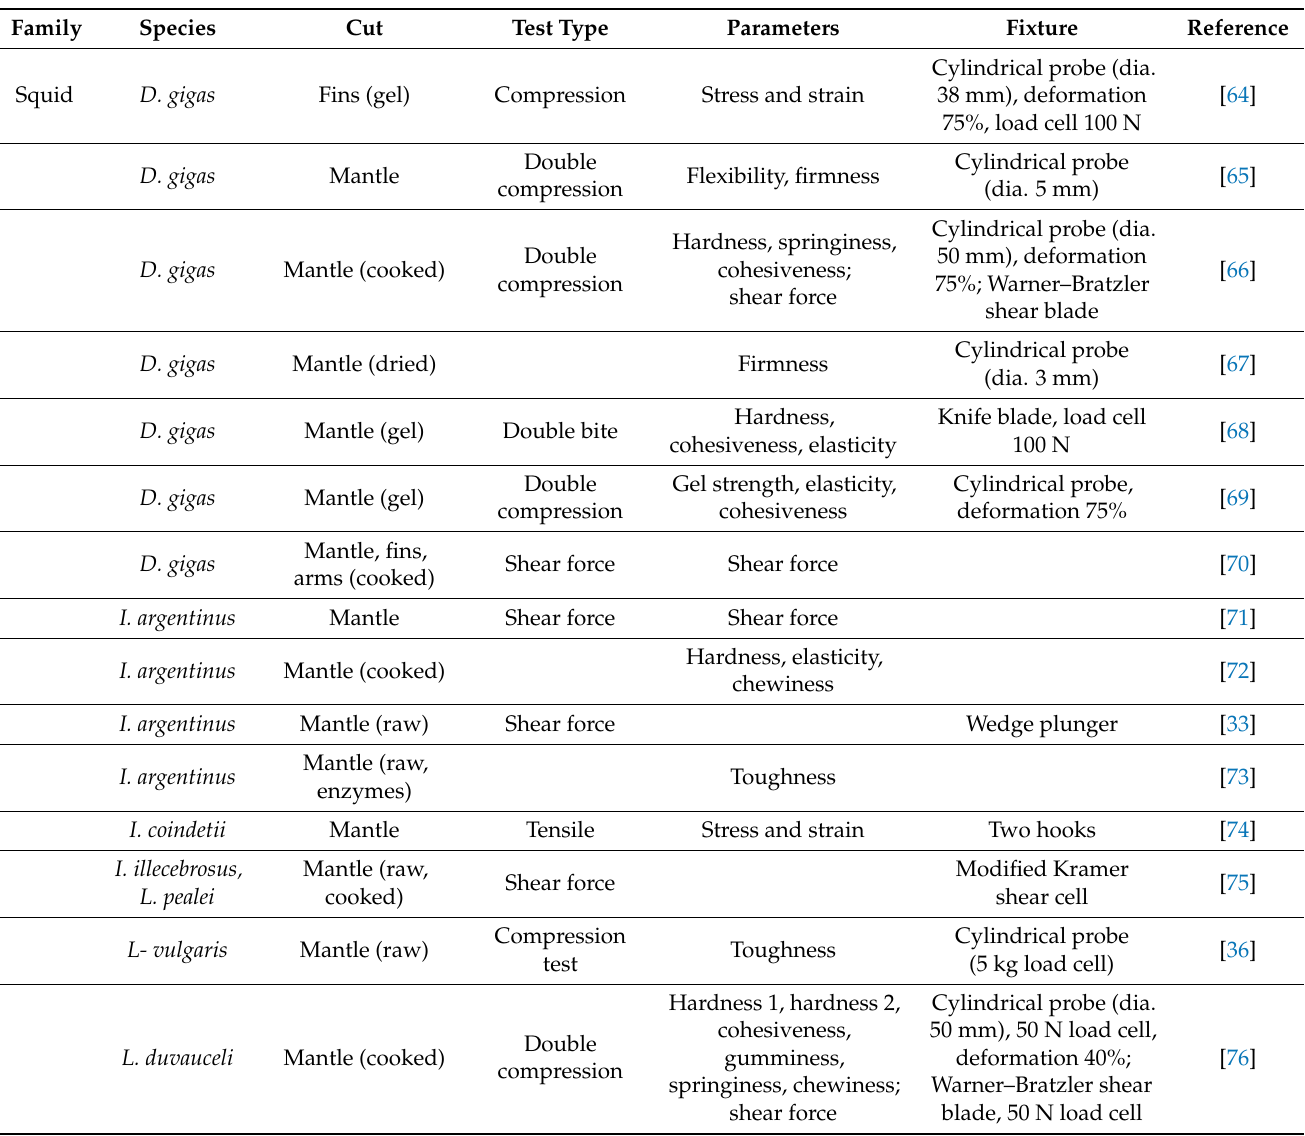
Table 2. Overview table of applied TA test types applied to analysing the mechanical texture of different species of